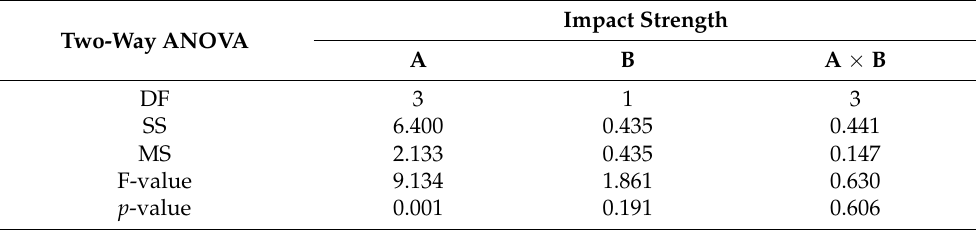
Table 3. Two-way ANOVA results of impact strength of the varied 3D printed PHB/UDMA. Two-Way